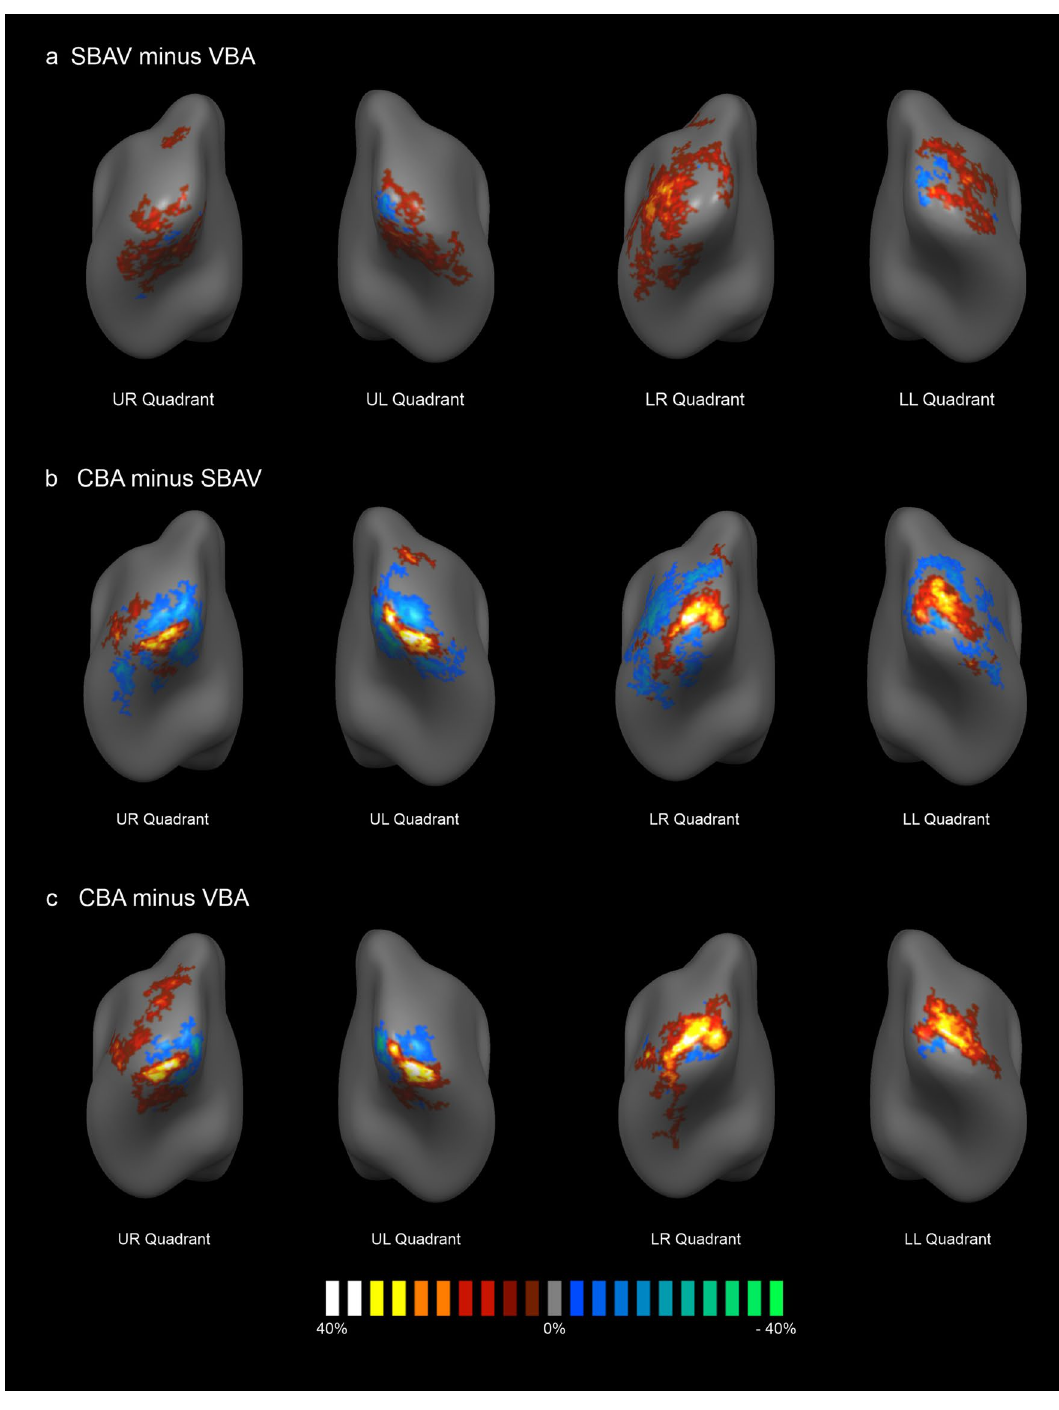
Figure 3. Probability Difference Maps (PDMs). PDMs indicating the differential impact of the individual steps of our overall macroanatomical alignment approach for each visual quadrant. PDMs were generated using PMs derived from single-subject maps. PMs were unthresholded. The color code indicates the difference of activation overlap. The color code brown-to-white indicates a higher degree of functional activation overlap for the more advanced alignment method. The color code blue-to-green indicates a higher degree of functional activation overlap for the less advanced alignment method. PDMs were thresholded at a minimum probability difference of 5%. ( a ) The impact of surface-based functional data readout and pre-processing compared to standard volume-based alignment (SBAV minus VBA) was characterized by a widespread activation with an increase in the probability of activation overlap of up to 30% around the central ROIs and a decrease in the probability of activation overlap of up to 19 % at the location corresponding to the central ROIs. ( b ) The additional impact of macroanatomical alignment (CBA minus SBAV) was less widespread but characterized by an increase in the probability of activation overlap of up to 44% at the location of the central ROIs and a decrease in the probability of activation overlap of up to 32% around the central ROIs. ( c ) The additive impact of both methodological elements (CBA minus VBA) was characterized by an increase in the probability of activation overlap of up to 52% at the location of the central ROIs and a decrease in the probability of activation overlap of up to 36% around the central